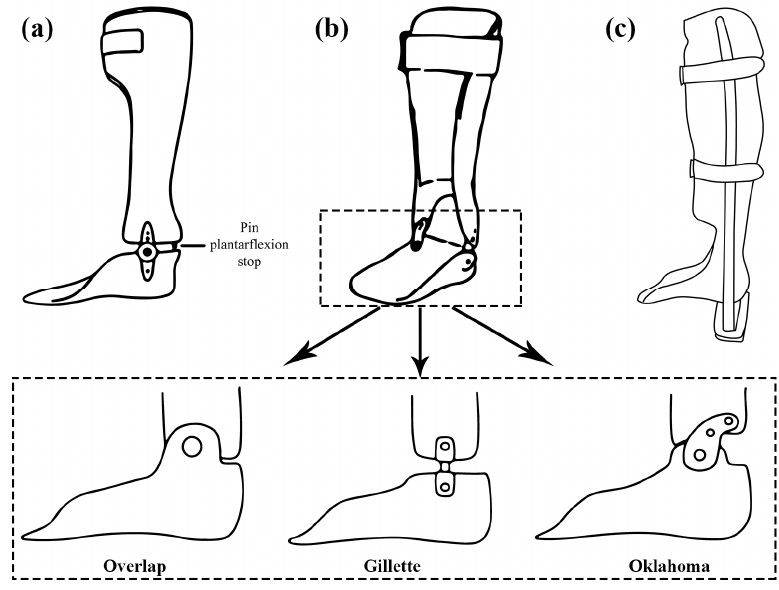
Figure 4. ( a ) Plantar- fl exion stop AFO, ( b ) hinged AFO, ( c ) patellar-tendon-bearing